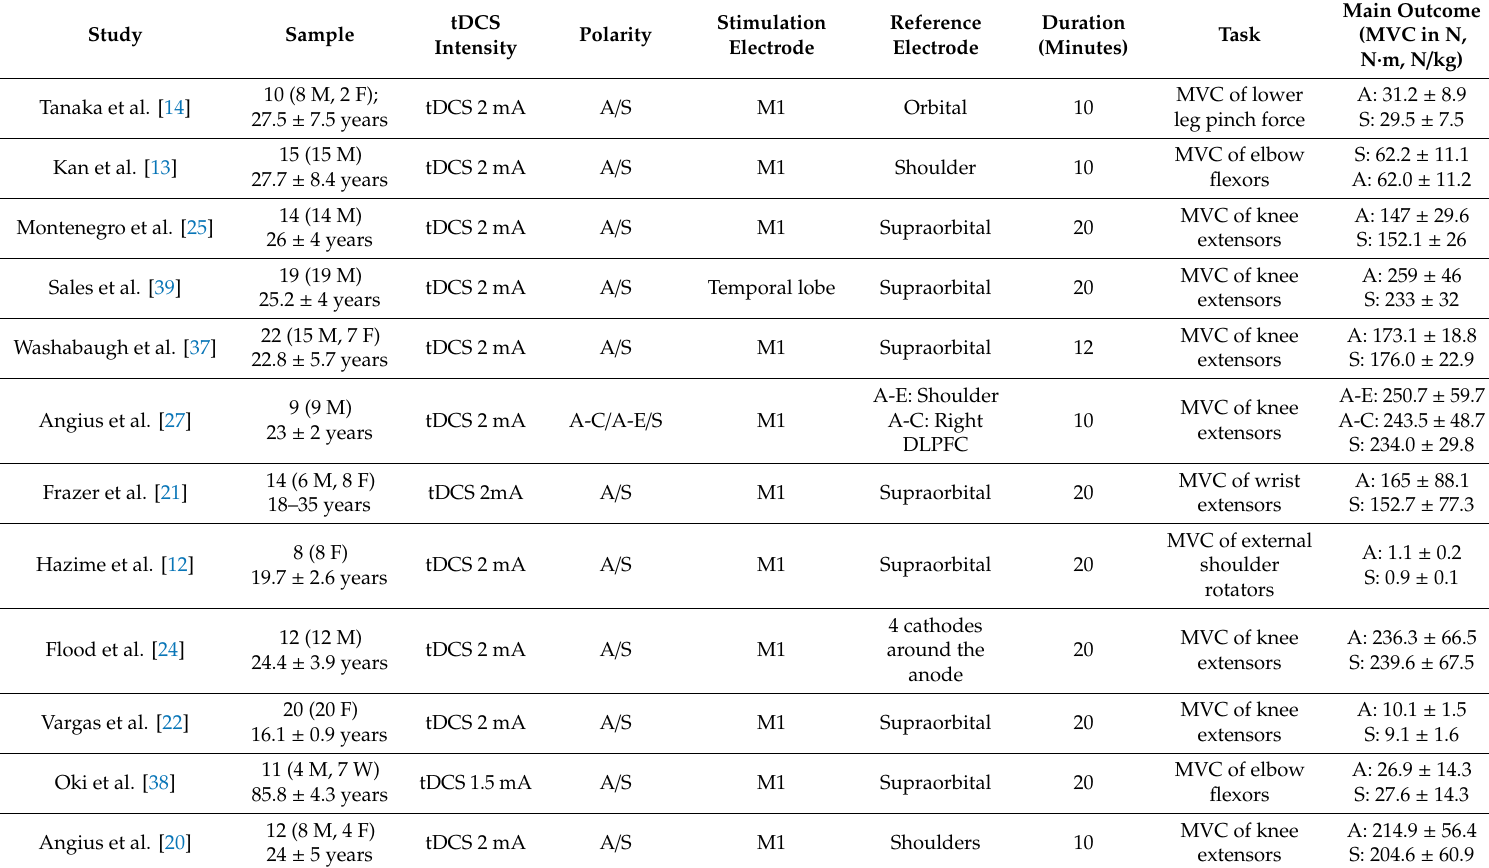
Table 1. Acute e ff ects of transcranial direct current stimulation (tDCS) on maximal voluntary contraction ( n = 12). tDCS Stimulation Study Sample Polarity Intensity